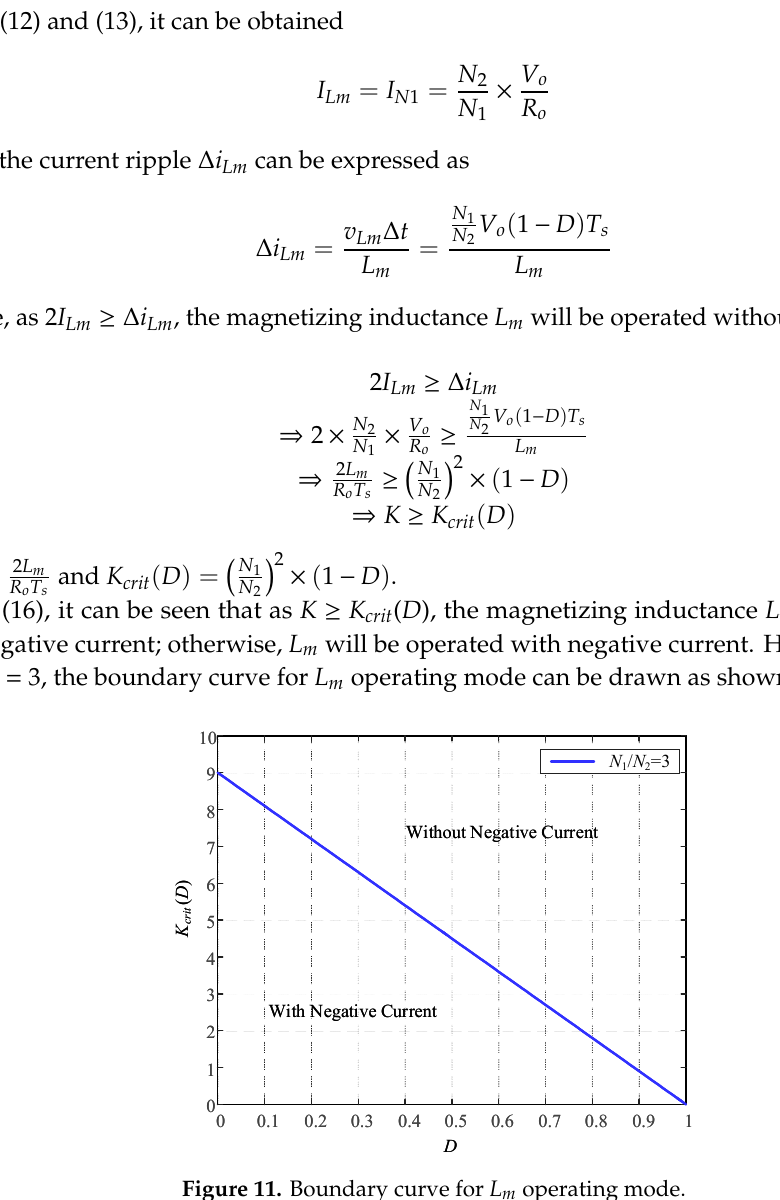
Figure 11. Boundary curve for L m operating mode.